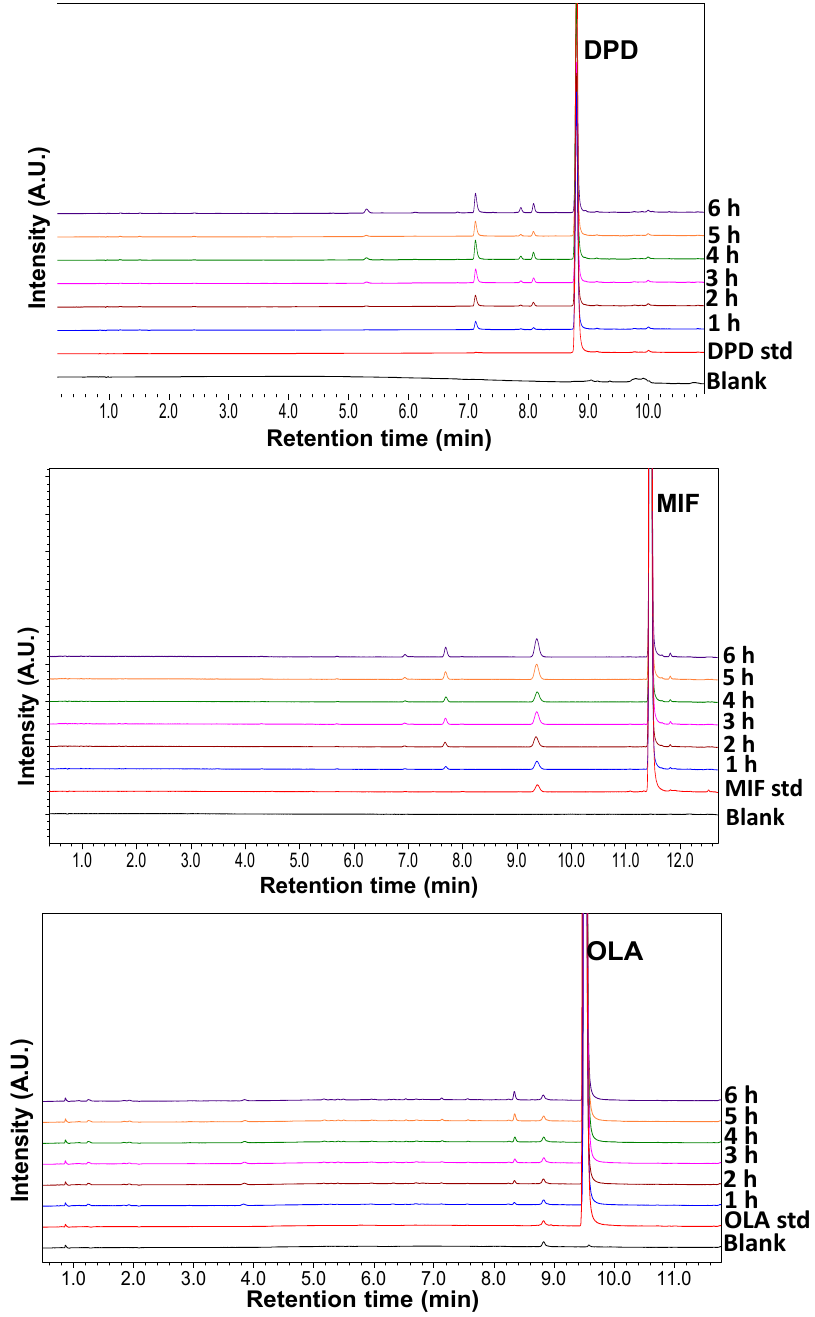
Figure 4. Overlaid zoomed chromatograms depicting enrichment of autoxidative DPs from drugs when dissolved in NMP and exposed in RapidOxy ® . No additional peaks were observed in the chromatogram beyond the displayed retention time range. Key: std-drug standard (time zero sample), 1–6 h are the selected kinetic time points.